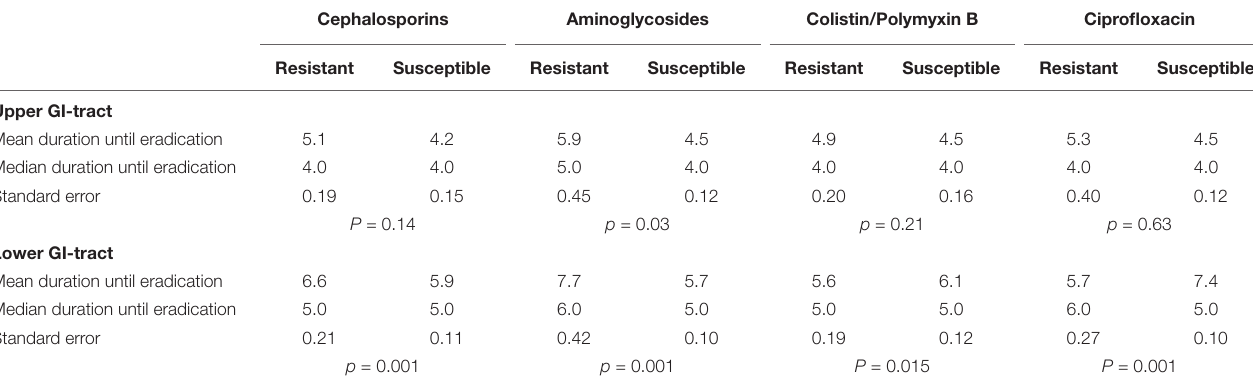
TABLE 1 | Mean and median duration until decontamination in days.